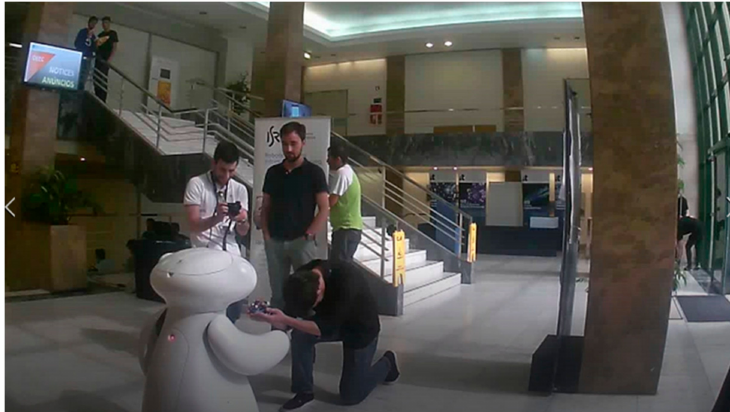
Figure 4. A student asking the robot for